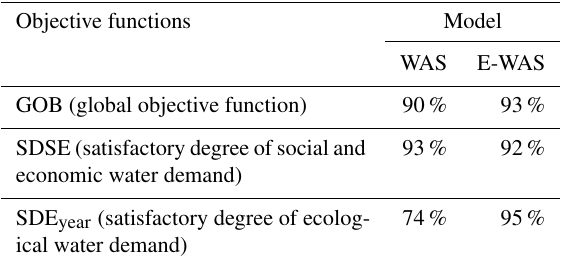
Table 6. Different objective function values in WAS and E-WAS. Objective functions Model